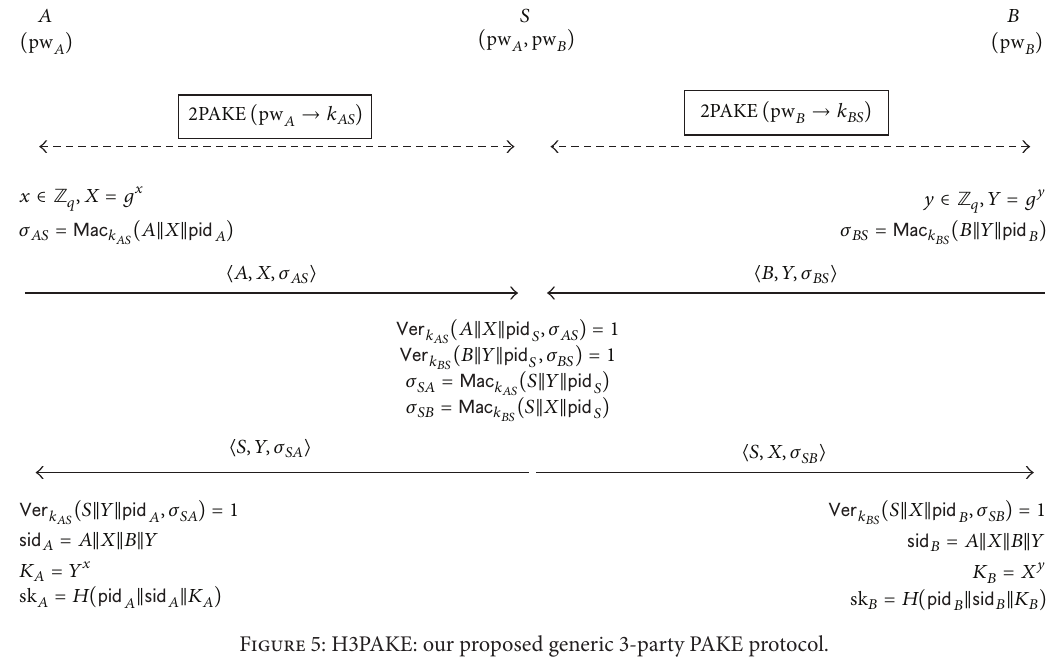
Figure 5: H3PAKE: our proposed generic 3-party PAKE